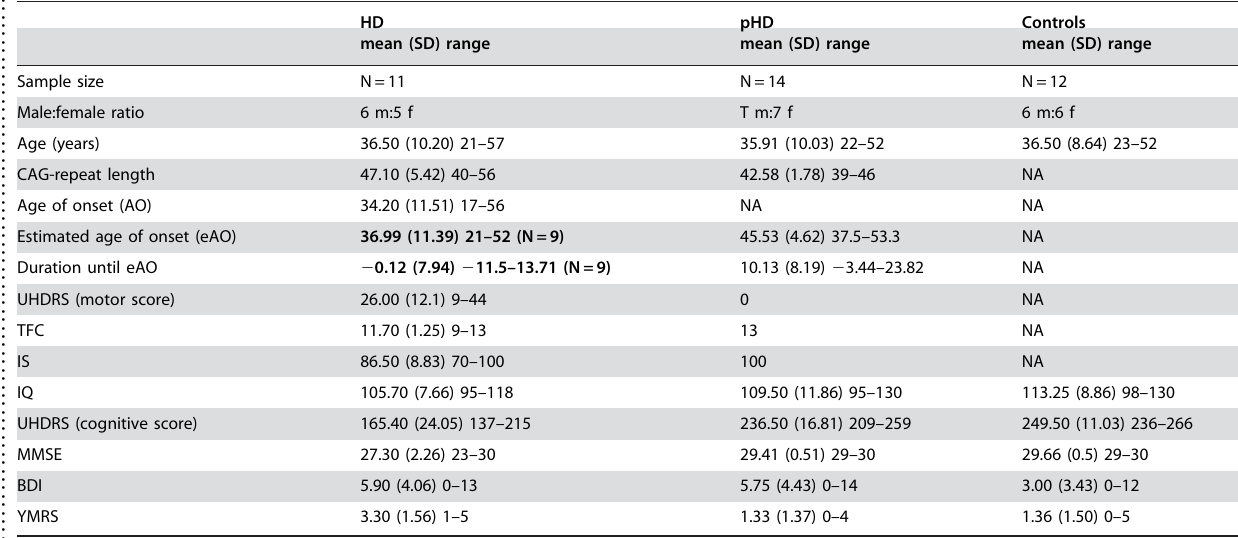
Table 1. Descriptive demographical and clinical data of the symptomatic group (HD), presymptomatic group (pHD) and